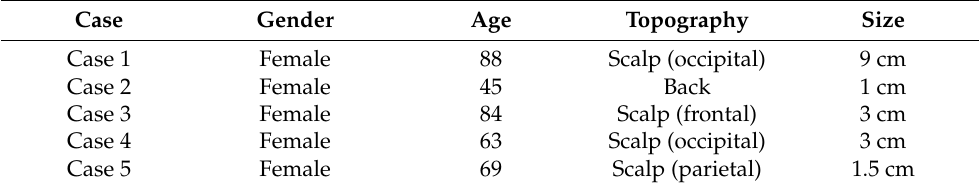
Table 1. Cases included in the study.